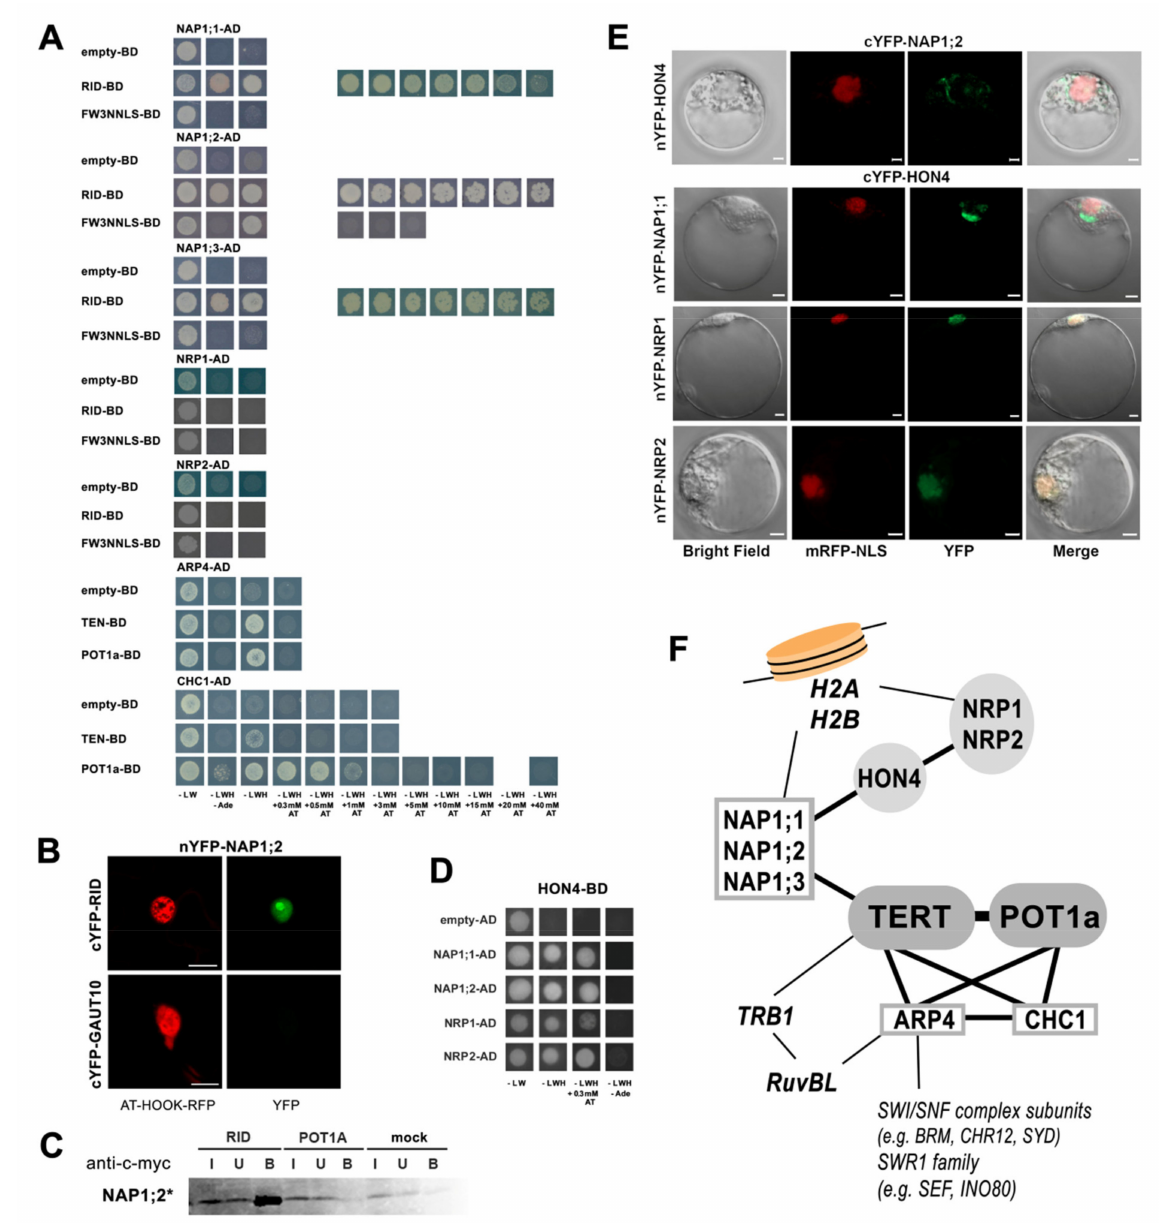
Figure 2. Interactions of nucleosome assembly proteins and chromatin remodeling proteins. ( A ) In Y2H assays, positive interactions between AtTERT constructs and NAP1;1, NAP1;2, and NAP1;3 proteins, but not with related NRP1 and NRP2 proteins, were detected. Chromatin remodeling proteins ARP4 and CHC1 showed interactions with TEN and POT1a. ( B ) A positive interaction in planta between nYFP-NAP1;2 and cYFP-RID constructs was localized in the nucleus and nucleolus using the BiFC assay in Nicotiana benthamiana leaves. The nYFP-GAUT10 construct served as a negative control, yellow fluorescence of BiFC interaction (YFP, green) and control nuclear marker (AT-HOOK-RFP, red) is shown, scale bar = 20 µ m. ( C ) The NAP1;2 interaction with the RID construct was confirmed by co-immunoprecipitation. RID and POT1a constructs with c-myc tag and NAP1;2 radioactively labeled (*) protein were produced in vitro in a rabbit reticulocyte lysate (RRL) system and a pull-down of interacting partners was performed with anti-c-myc magnetic beads (I, input; U, unbound; B, bound). ( D – F ) Positive interactions between the HON4 protein and members of the nucleosome assembly family proteins were detected in Y2H ( D ) and localized in BiFC assays ( E ). HON4 interacts with NAP proteins in cytoplasmic foci and the interaction between HON4 and